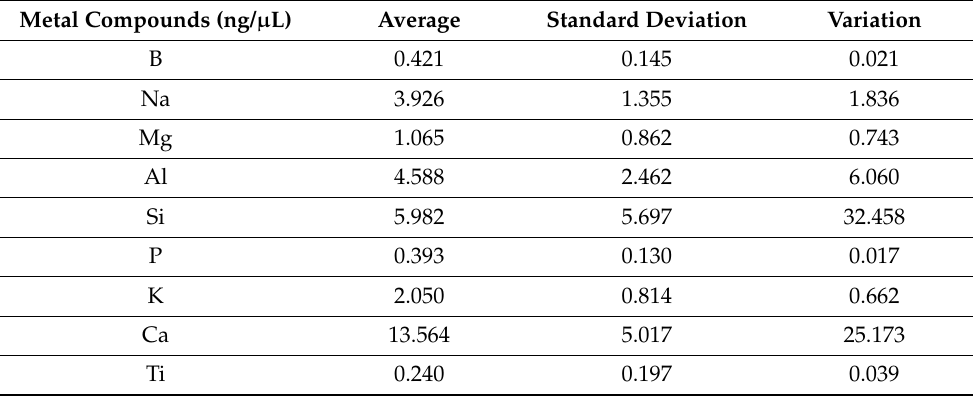
Table 6. Metal components in the TSP samples at 20